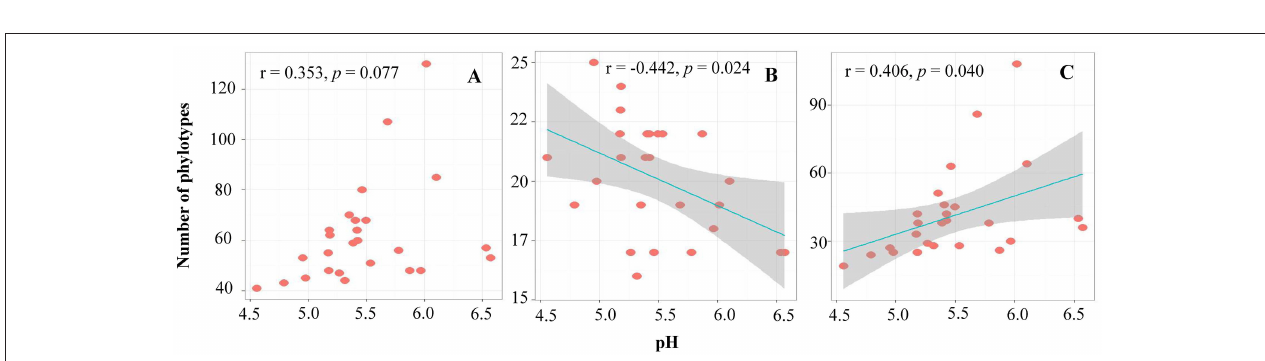
FIGURE 2 | The relationship between soil pH and OTU numbers of total archaea (A) , Thaumarchaeota (B) , and Euryarchaeota (C) .